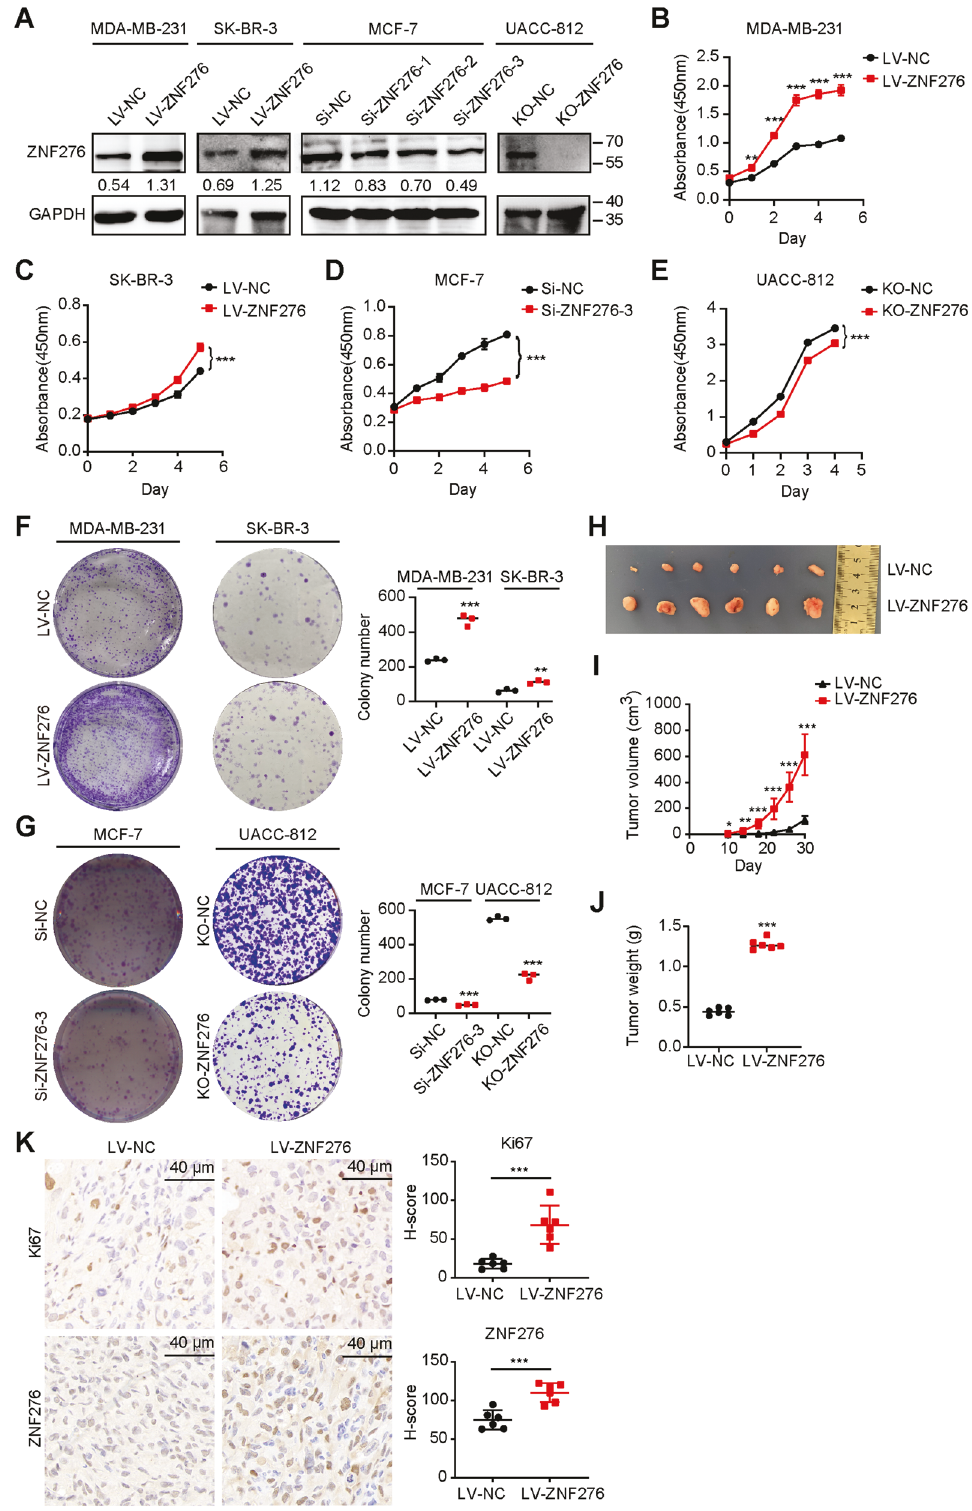
Fig. 2 ZNF276 promotes the proliferation of breast cancer cells. A Western blot identifying the ZNF276 overexpression in MDA-MB-231 and SK-BR-3, ZNF276 knockdown in MCF-7 and ZNF276 knockout in UACC-812. B-C. CCK-8 assay measuring the effect of ZNF276 overexpression on cell proliferation in MDA-MB-231 ( B ) and SK-BR-3 ( C ) cells. D , E The effect of ZNF276 silencing ( D ) and knockout ( E ) on cell proliferation was evaluated by CCK-8 assay. F Cell proliferation ability of ZNF276 overexpressing cells was measured by clone formation assay. G Clone formation assay measuring the effect of ZNF276 silencing and knockout on cell proliferation. H ZNF276 overexpression affecting breast cancer tumor formation in the mammary fat pad of nude mice. I Measurement of tumor volume of the resected tumors from mice injected with ZNF276 overexpressing cells and control cells. J Statistical analysis of tumor weight of the resected tumors. K Immunohistochemical staining of Ki67 and ZNF276 in the resected tumors. Bar = 40 µm. * p < 0.05; ** p < 0.01; *** p < 0.001. Cell Death and Disease (2022)